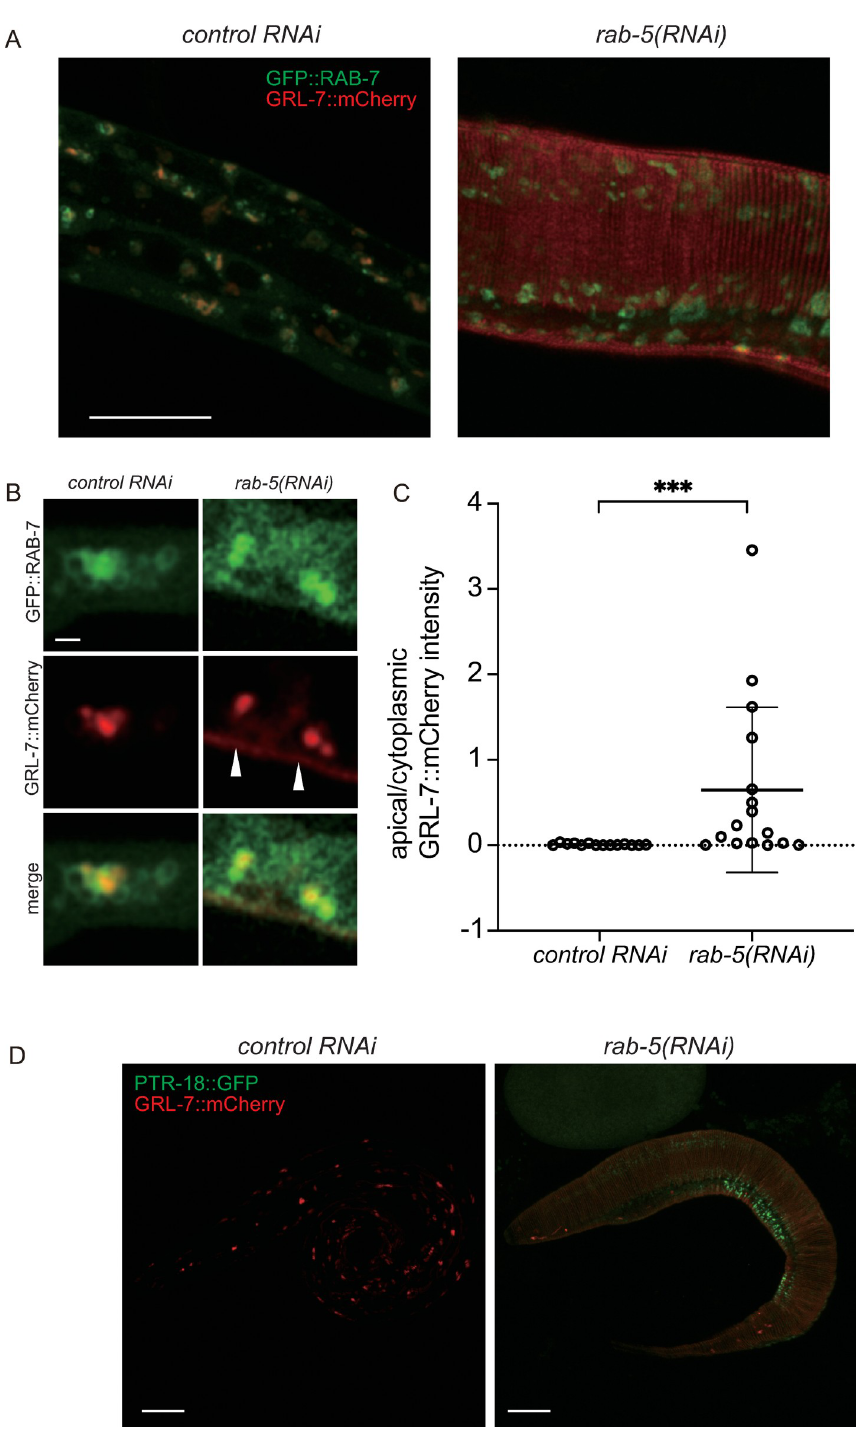
Fig 6. GRL-7::mCherry and PTR-18::GFP are internalized via endocytosis. (A) Images of maximum intensity Z projections showing a part of the bodies of newly hatched larvae. Note the apical localization of GRL-7::mCherry in the rab-5(RNAi) animal. Scale bar: 10 μ m. (B) Magnified images of RNAi-treated animals. Apically localized GRL-7:: mCherry are indicated by arrowheads. Scale bar: 1 μ m. (C) Quantitation of fluorescence intensity of apical and cytoplasmic GRL-7::mCherry. Localization of apical and cytoplasmic GRL-7::mCherry are defined by the area outside and within GFP::RAB-7 distribution, respectively. ��� : P < 0.001 (unpaired two-sided t-test). (D) Apical localization of PTR-18::GFP are detected in newly hatched rab-5(RNAi) larvae. Images of maximum intensity Z projections are shown. Scale bar: 10 μ m.